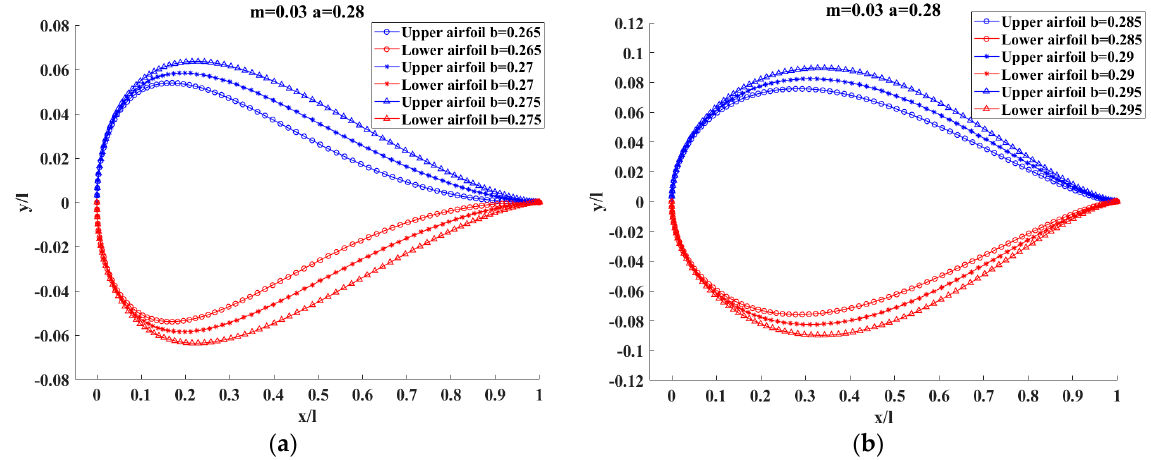
Figure 5. Influence of the real axis translation parameter on airfoil shape. ( a ) Airfoil when the value of b is less than the value of a ; ( b ) Airfoil when the value of b is greater than the value of a .